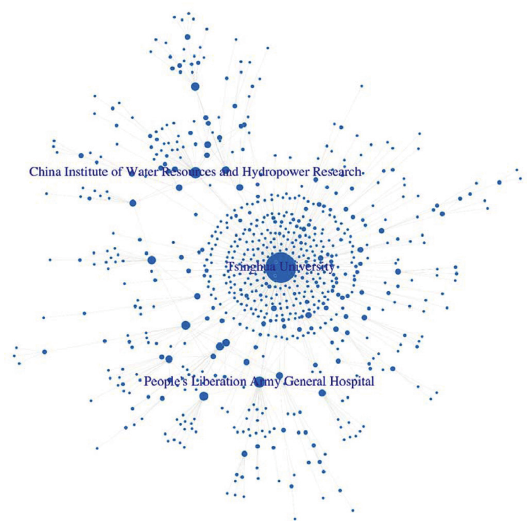
Figure 6: Tsinghua Community of Innovation with single-center structure.